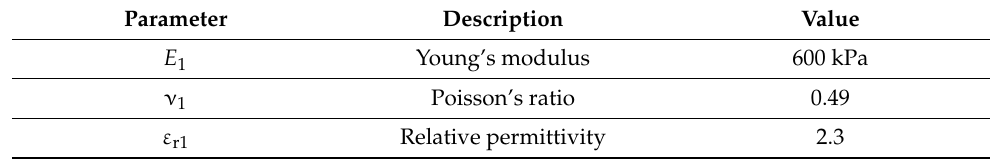
Table A2. Material parameters of Ecoflex.